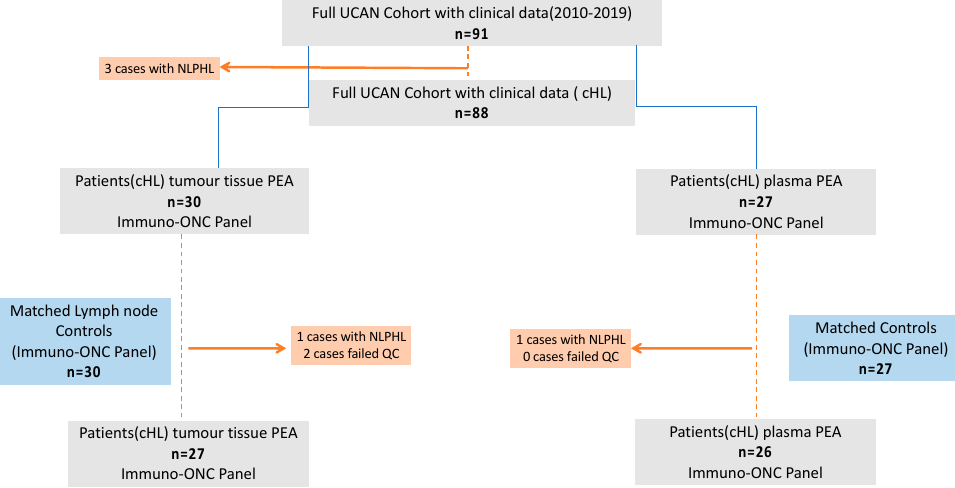
Figure 1. Flowchart of patients included in the current study: UCAN = Uppsala Umeå Comprehen- sive Cancer Consortium biobank program, cHL = classical Hodgkin lymphoma, NLPHL = nodular lymphocyte-predominant Hodgkin lymphoma, QC = quality control, PEA = proximity extension assay, and Immuno-ONC =